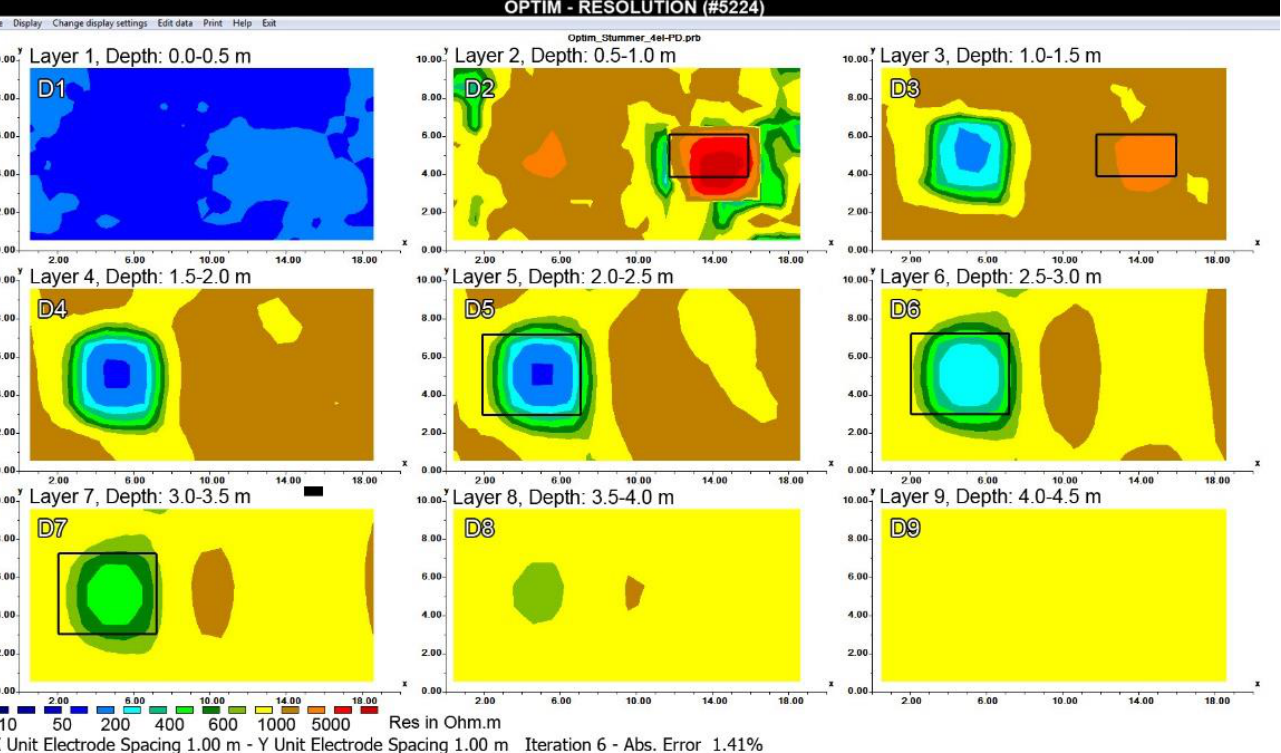
Figure 9. Inversion results from FULL optimum array produced by Stummer’s algorithm. Figure 10. Inversion results from FULL optimum array produced by Stummer’s